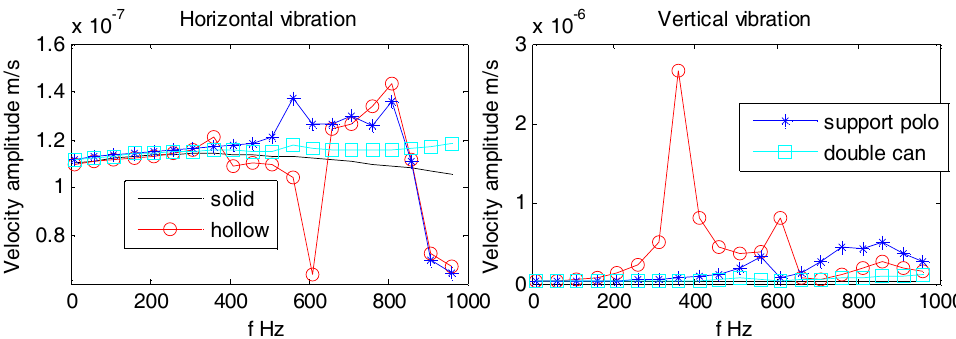
Figure 21. Vibration velocity amplitudes of OBSs with different compartments under incident 10 ° .